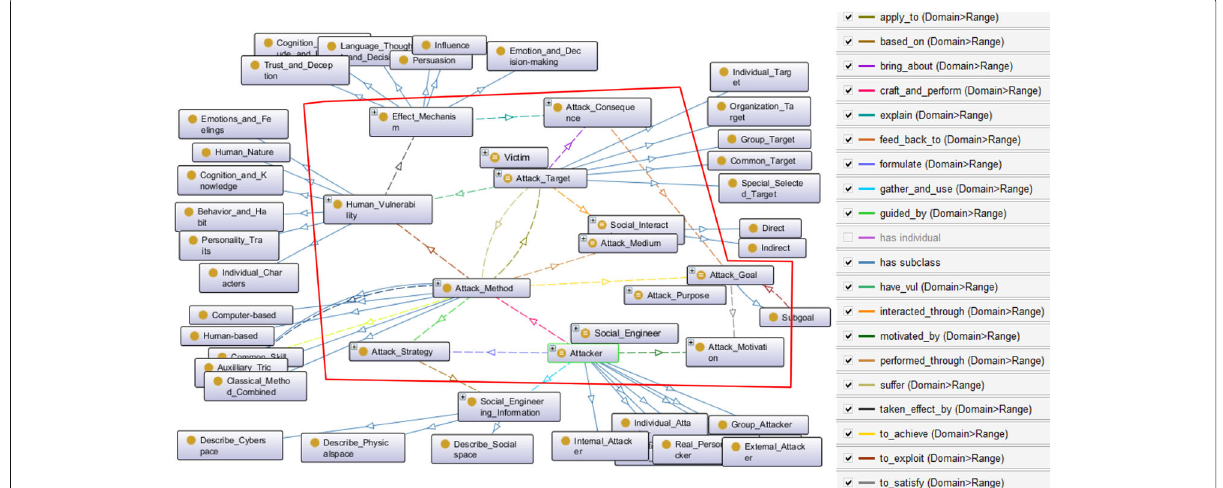
Fig. 16 The domain ontology of social engineering in cybersecurity developed in